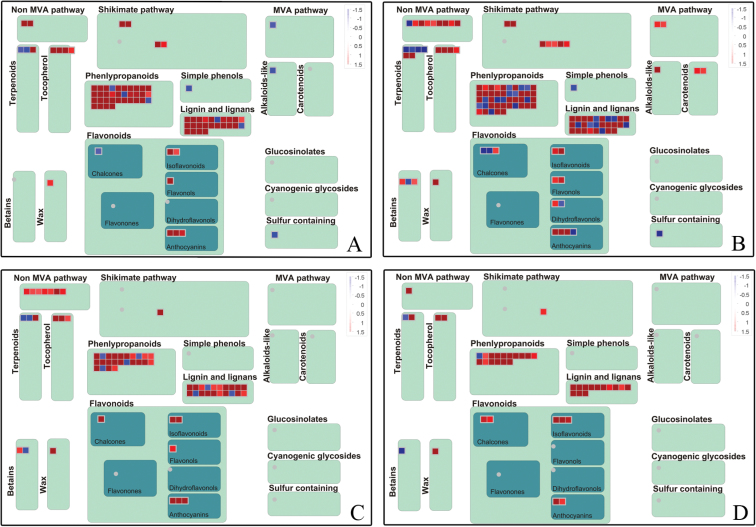
Schematic of the secondary metabolism pathway using the MapMan visualization platform. The red or blue squares indicate the up- or down-regulated genes involved in secondary metabolism pathways at 12 (A), 24 (B), 48 (C), and 72 HPT (D). (This figure is available in colour at JXB online.)